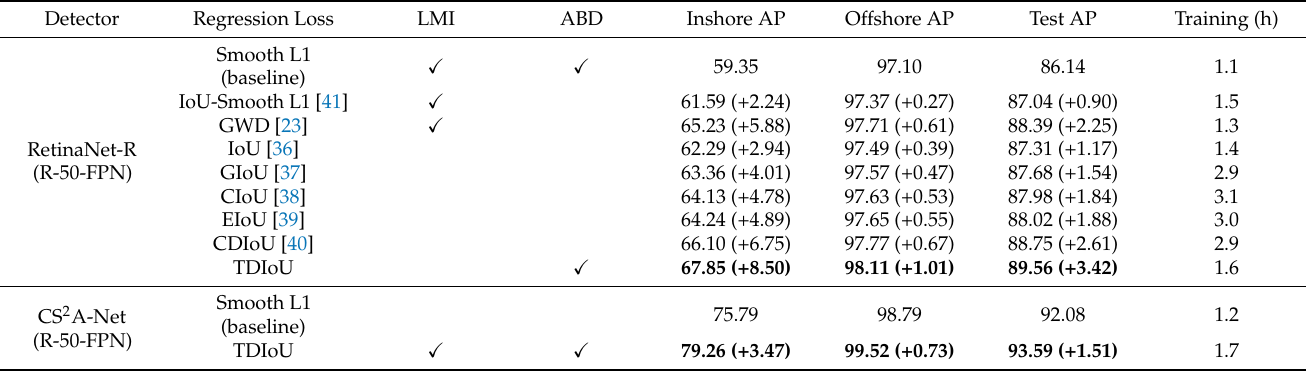
Table 5. Comparison of different regression losses on SSDD.